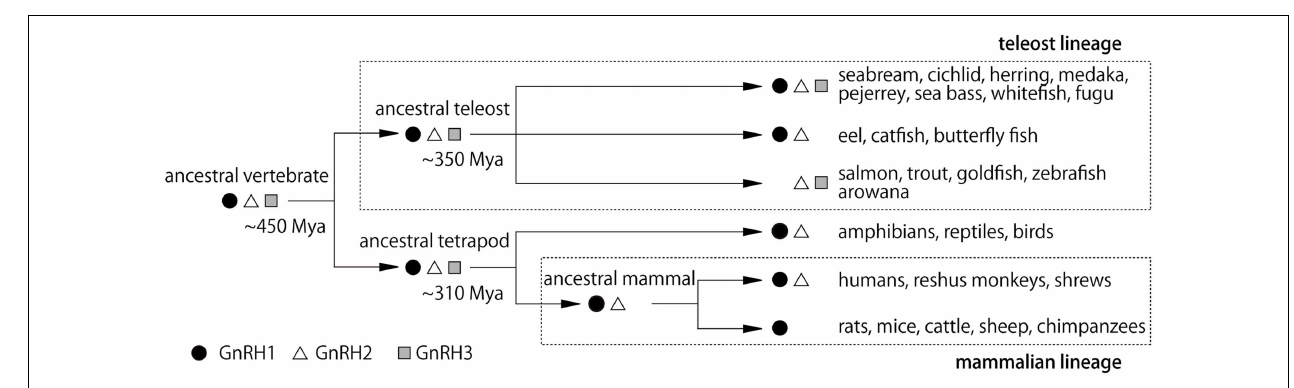
FIGURE 2 | Hypothetical scheme for the evolution of GnRH peptides in vertebrates . Mya, million years ago (4).